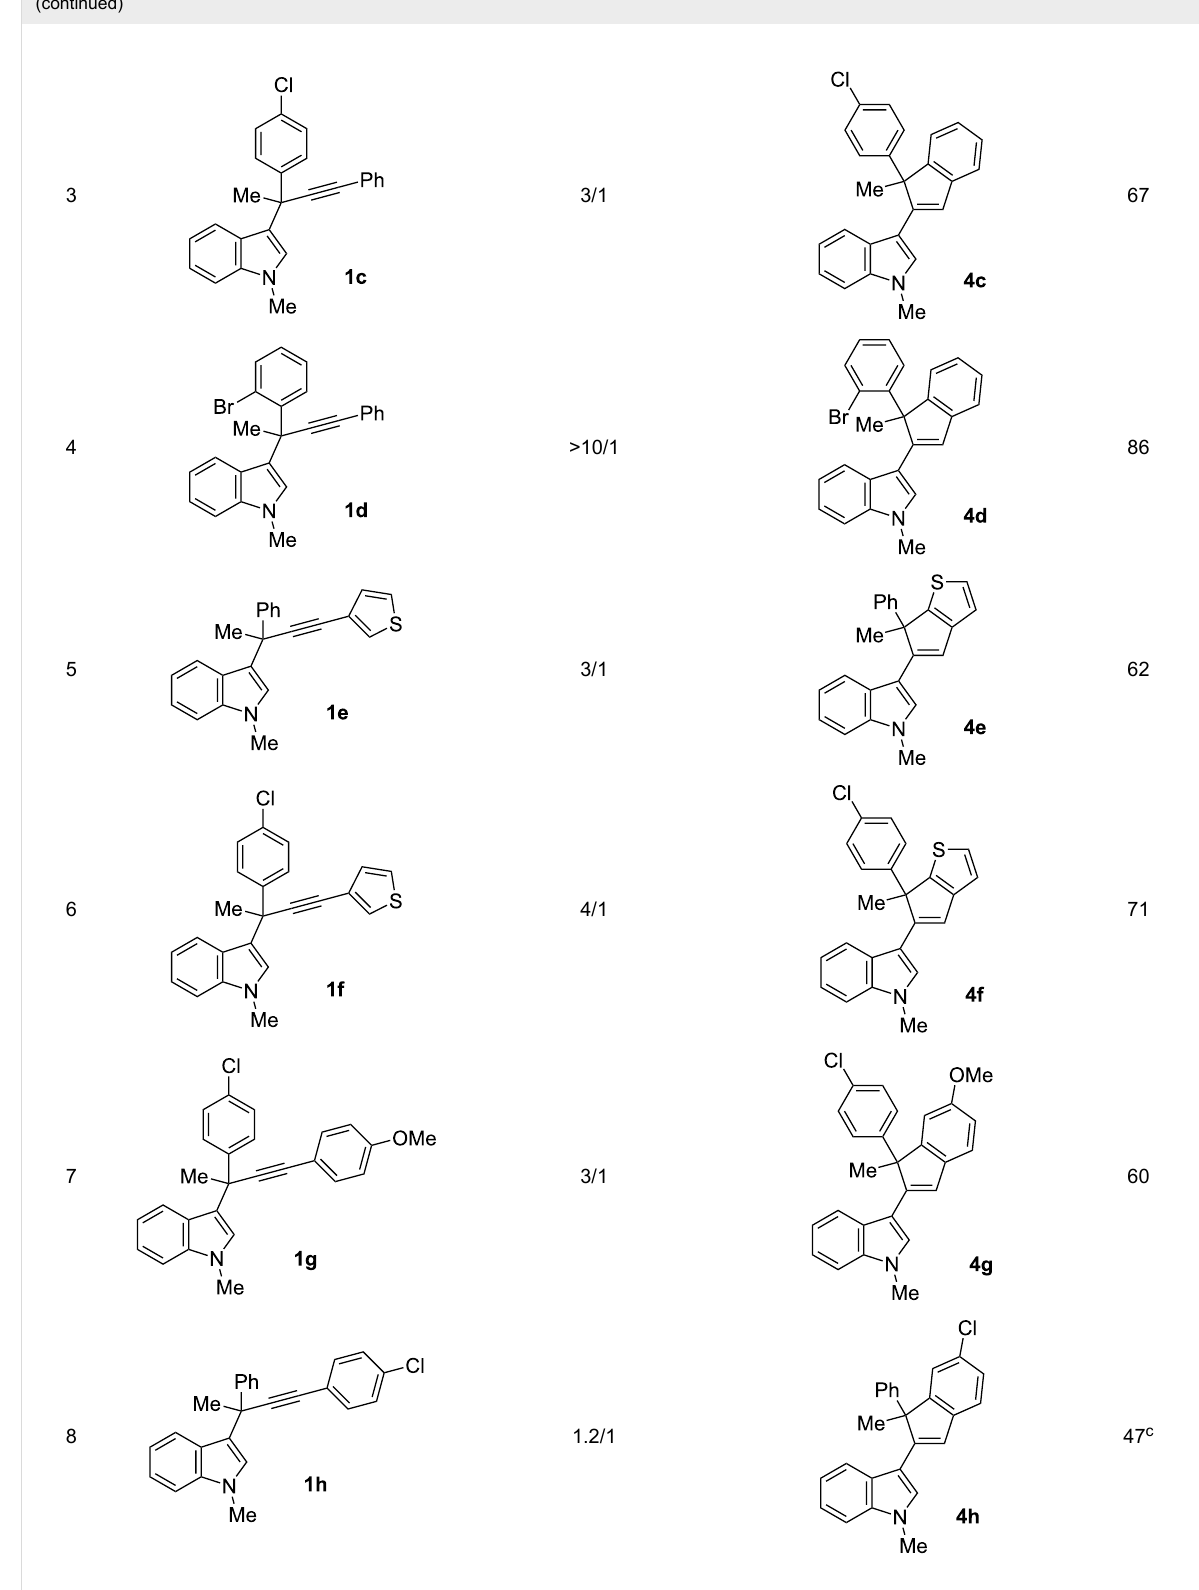
Table 2: Synthesis of 3-(inden-2-yl)indoles 4 by gold-catalyzed tandem 1,2-indole migration/Nazarov-type cyclization of 3-propargylindoles 1 .